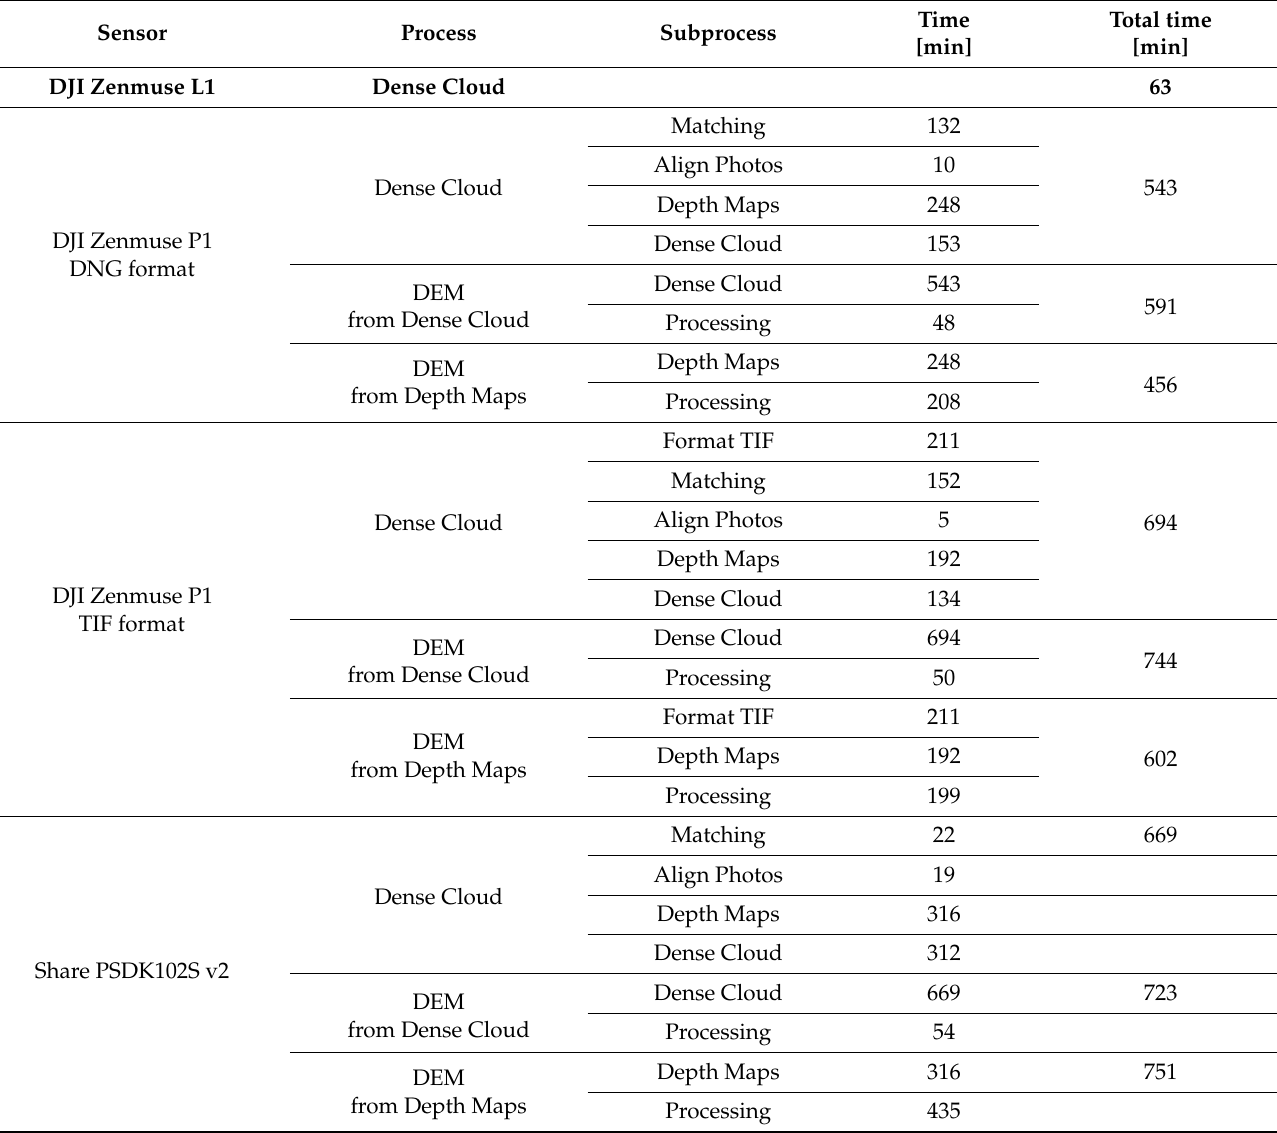
Table 2. Product generation